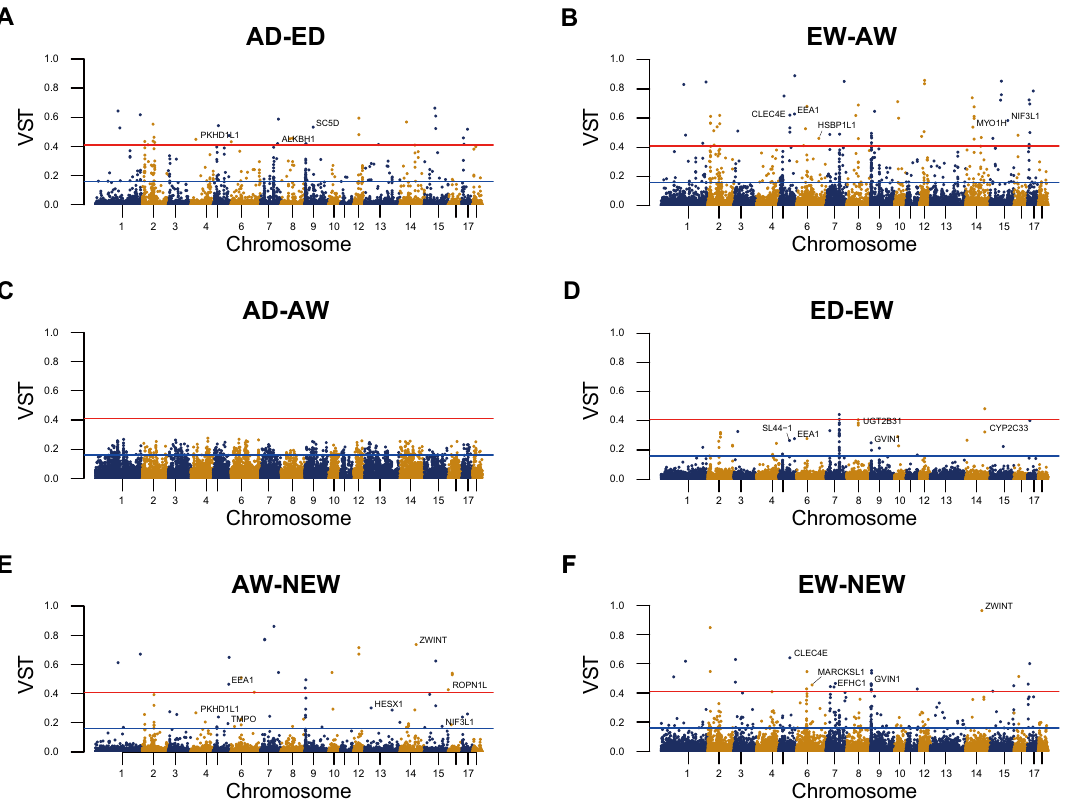
Figure 3. Manhattan plot of V ST . V ST of genes on autosomal CNVRs were visualized as Manhattan plots. The center point of genes was used as an x-coordinate value. Genes with significantly different pairwise V ST in upper 0.1% were marked by their names. Name of hypothetical, putative, predicted or uncharacterized genes and pseudo-genes were excluded due to lack of space. The upper 1% percentile V ST , 0.157, and upper 0.1% percentile, 0. 409, were shown as blue and red lines,